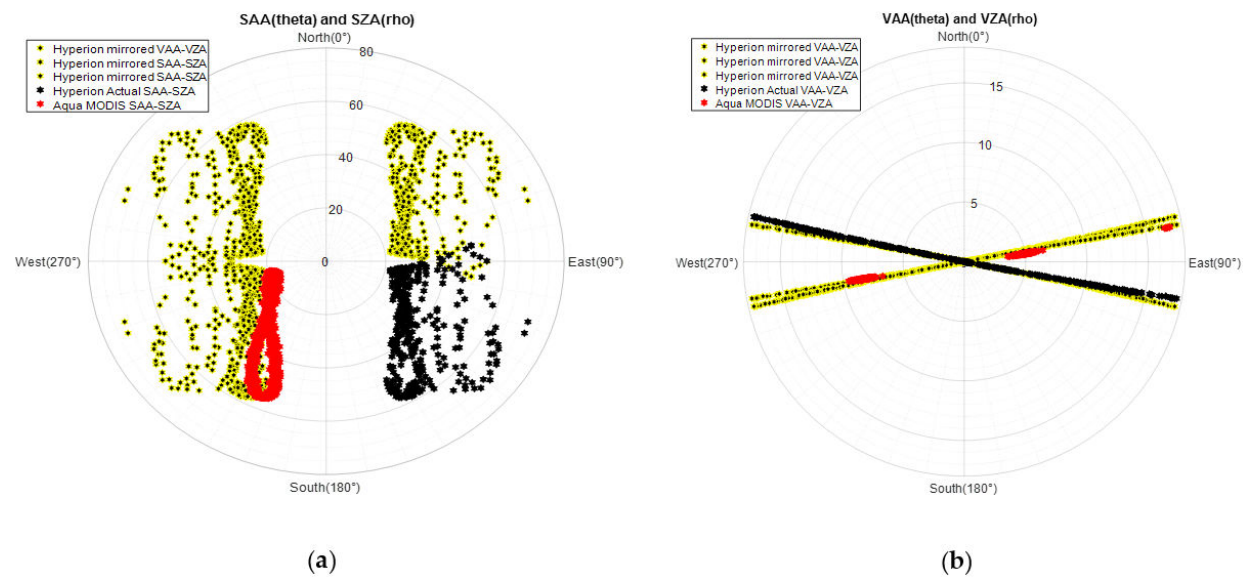
Figure 16. Comparison between Hyperion and Aqua MODIS angles in Polar plot ( a ) solar and ( b ) view geometries. Black asterisk (Actual Hyperion angles); Yellow asterisk (Mirrored Hyperion angles); Red asterisk (Actual Aqua MODIS